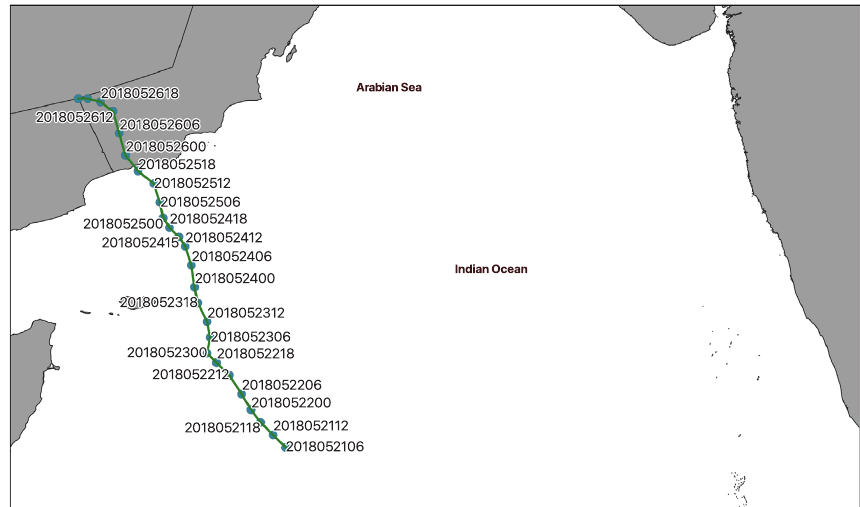
Figure 15: The best track of the TC “Mekunu” (source: